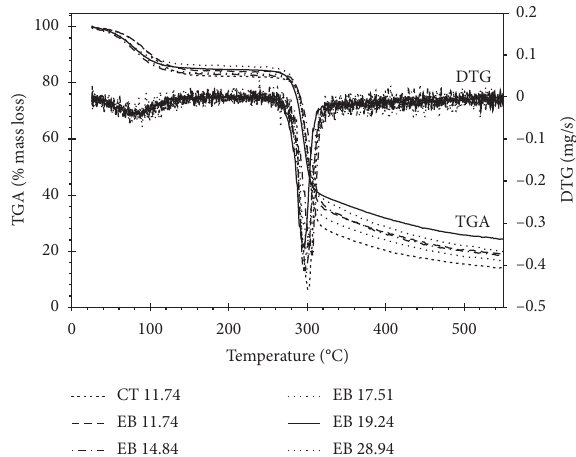
Figure 3: TGA-DTA curves of starch